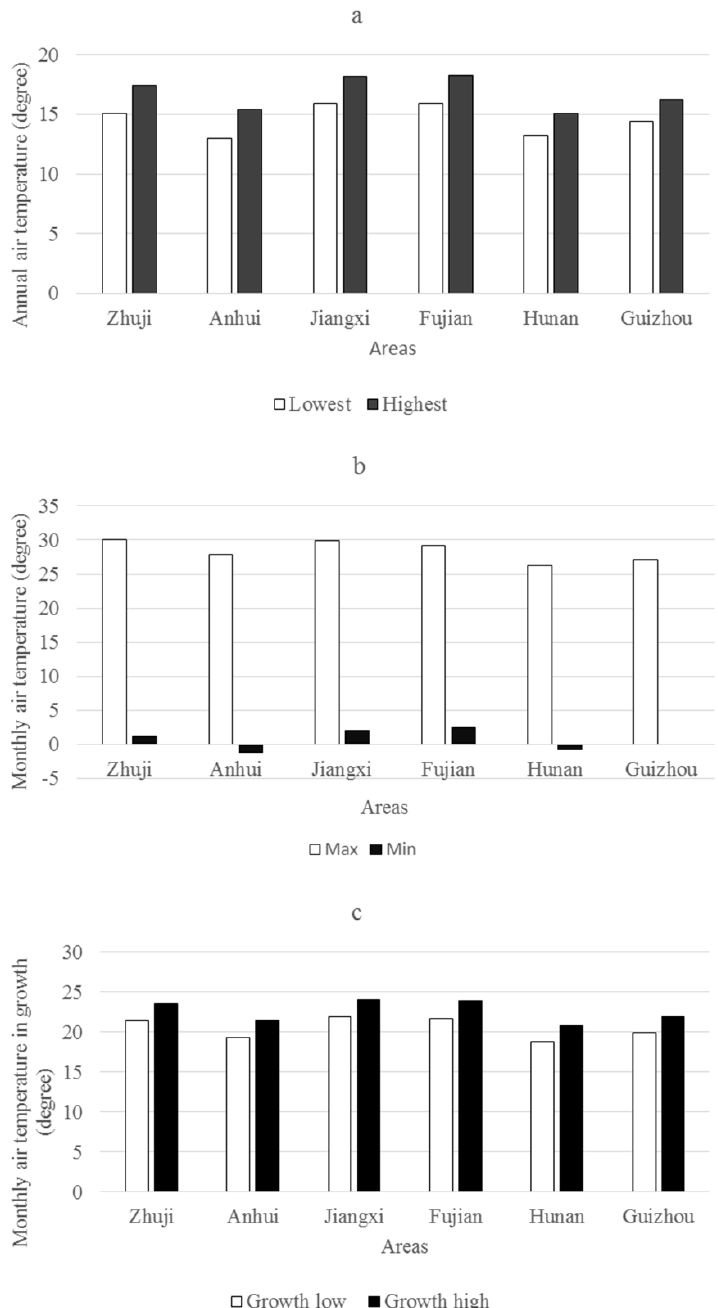
Figure 5. The lowest and highest values of annual air temperature varied at the six regions of Chinese Torreya plantations ( a ), the maximum (Max) and minimum (Min) values of monthly air temperature ( b ), and average monthly air temperature in the growing season ( c ).